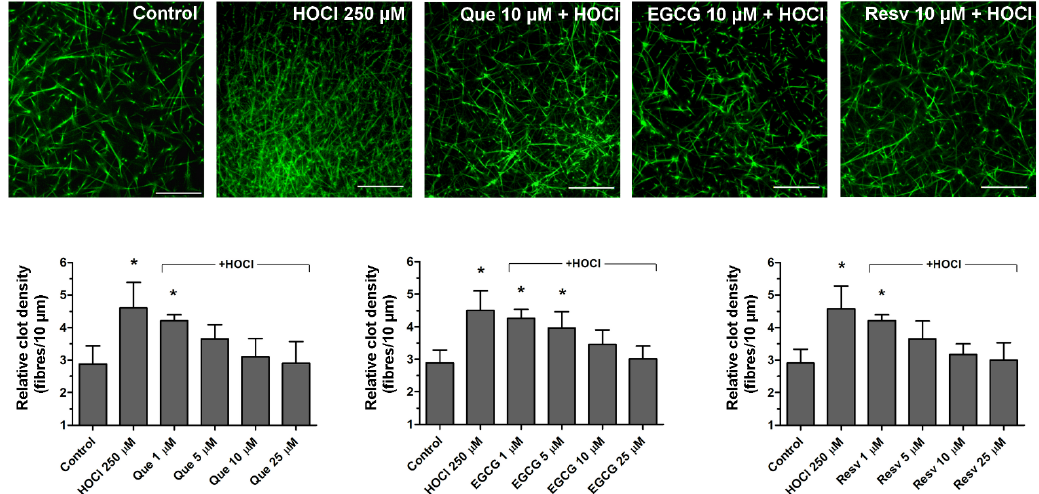
Figure 3. Effects of quercetin, epigallocatechin gallate, and resveratrol on HOCl-related increase in fibrin clot density. Plasma samples were incubated with appropriate vehiculum (ethanol or water) or with HOCl (250 μ M for 5 min) or with indicated concentrations of Que, EGCG, or Resv, added 1 min before HOCl. Afterward, samples were supplemented with AF488-fibrinogen (to visualize fibrin formation) and clotting was triggered by recalcification (20 mM CaCl 2 , final conc.). Result fibrin clots were analyzed under confocal microscope toward fibrin density. Structures representative of six independent experiments are presented. Bars are means ± S.D. from six experiments. * p < 0.05 vs. control. Distance bar is 30 μ m. Incubation of plasma samples with HOCl (125 μ M) resulted in the formation of lysis- resistant clots after recalcification, i.e. prolongation required to obtain 50% and 100% of clots lysis was recorded. Que (10–50 μ M), EGCG (10–50 μ M), or Resv (5–50 μ M) normalized fibrinolysis after 1 min preincubation (Figure 4). Que, EGCG, and Resv per se did not affect fibrinolysis at the studied concentrations (data not shown).